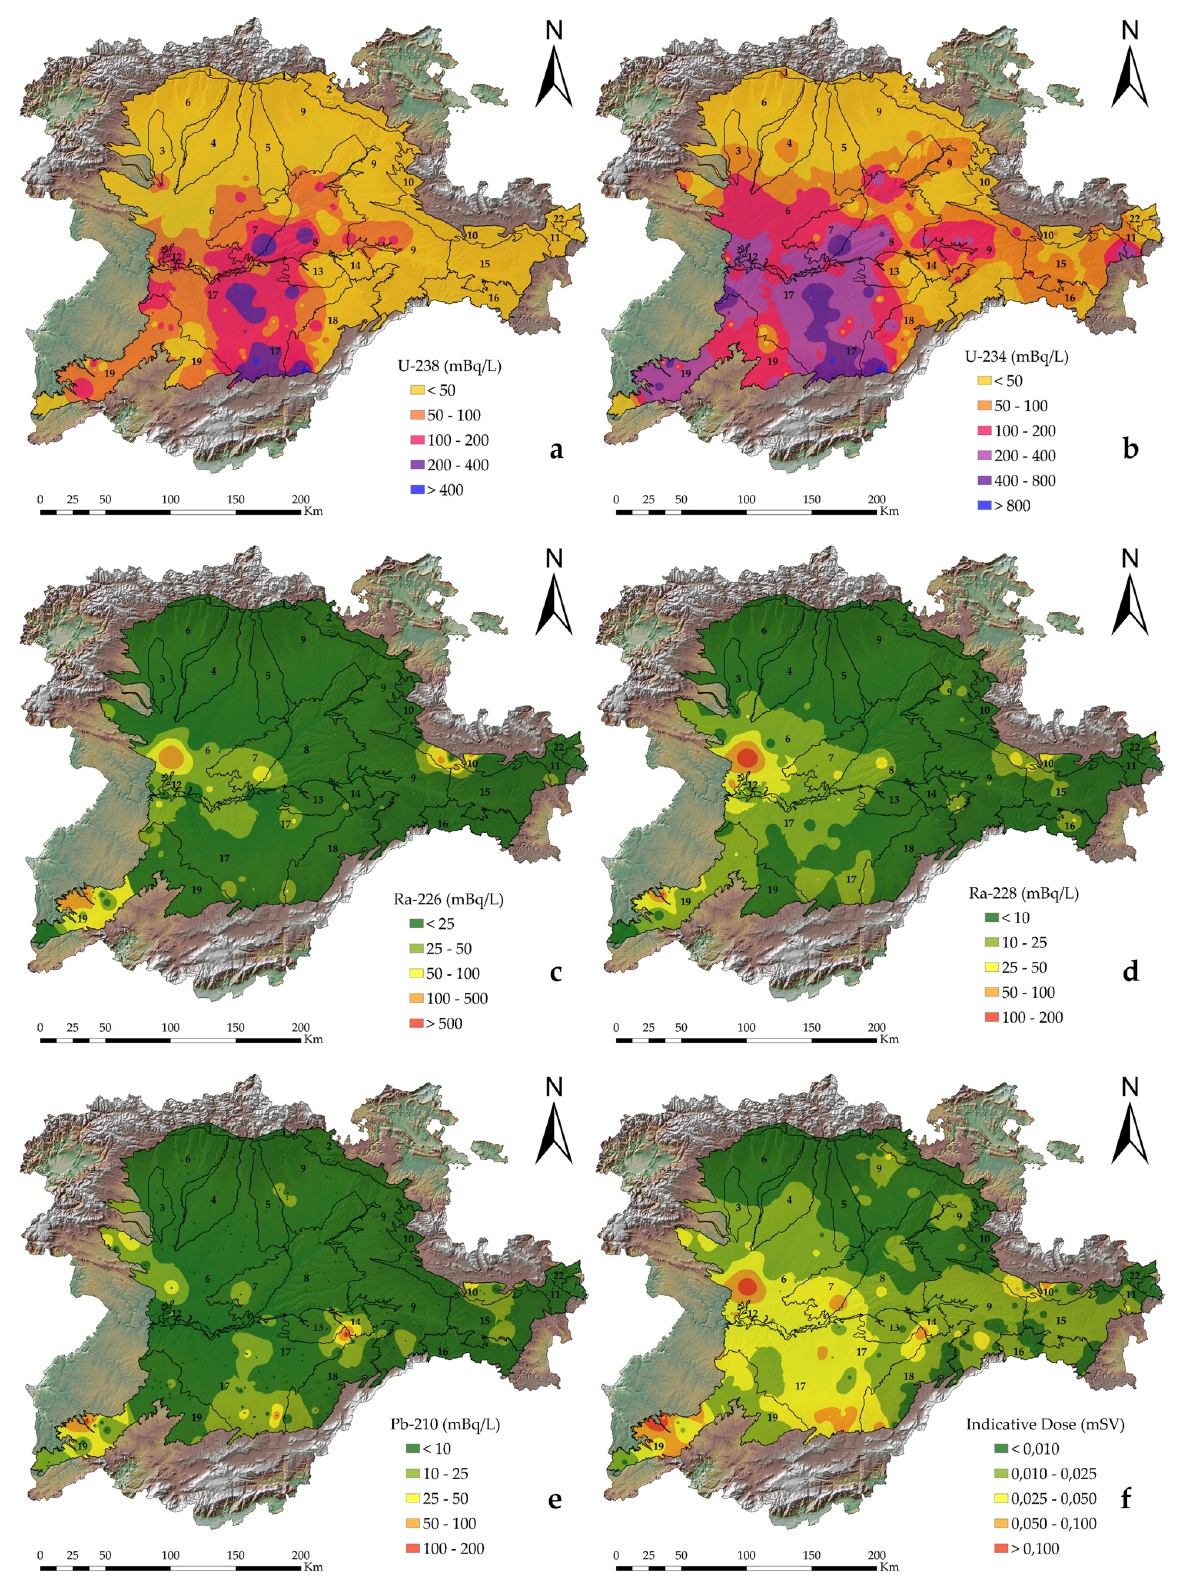
Figure 4. Spatial distribution of the main natural radionuclides in groundwater and the ID . IDW interpolation technique was applied: ( a ) 238 U activity concentration; ( b ) 234 U activity concentration; ( c ) 226 Ra activity concentration; ( d ) 228 Ra activity concentration; ( e ) 210 Pb activity concentration; ( f ) ID . The hydrogeological unit names corresponding to the numbers illustrated are referred to in Figure